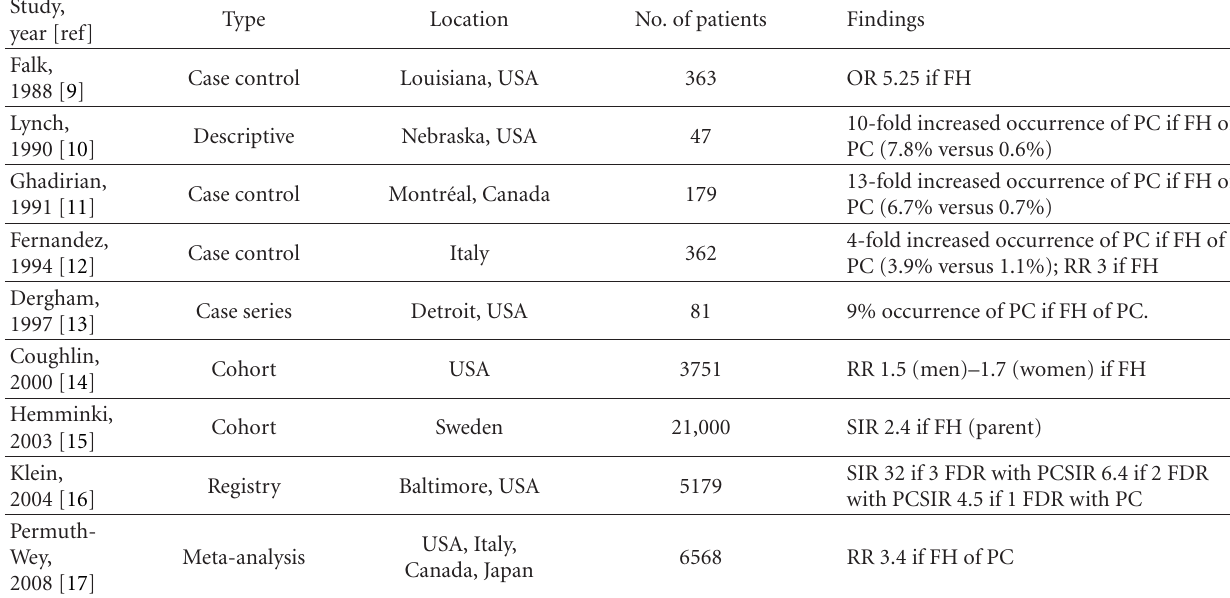
Table 1: Epidemiological studies of